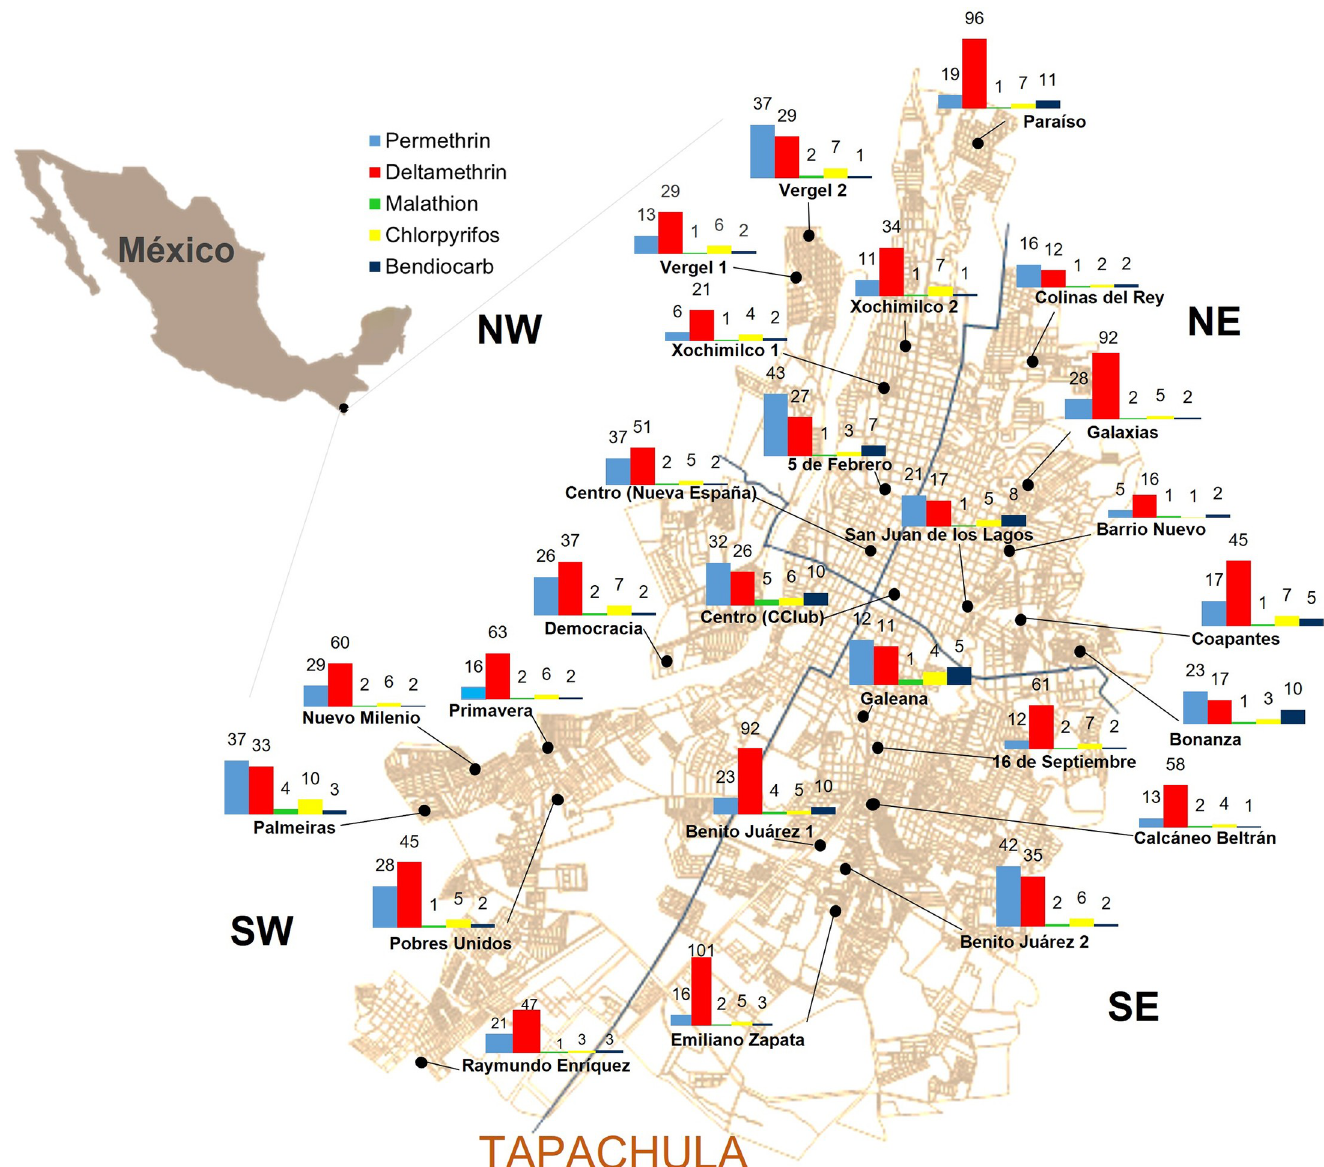
Fig 1. Spatial distribution of insecticide resistance to five compounds in Aedes aegypti collected in Tapachula. The number above each bar corresponds to the resistance ratio (RR). The RR was calculated relative to the susceptible New Orleans reference strain. Map obtained from the National Institute of Statistics and Geography (INEGI). Digital Map of Mexico. MDM: http://gaia.inegi.org.mx/mdm6.